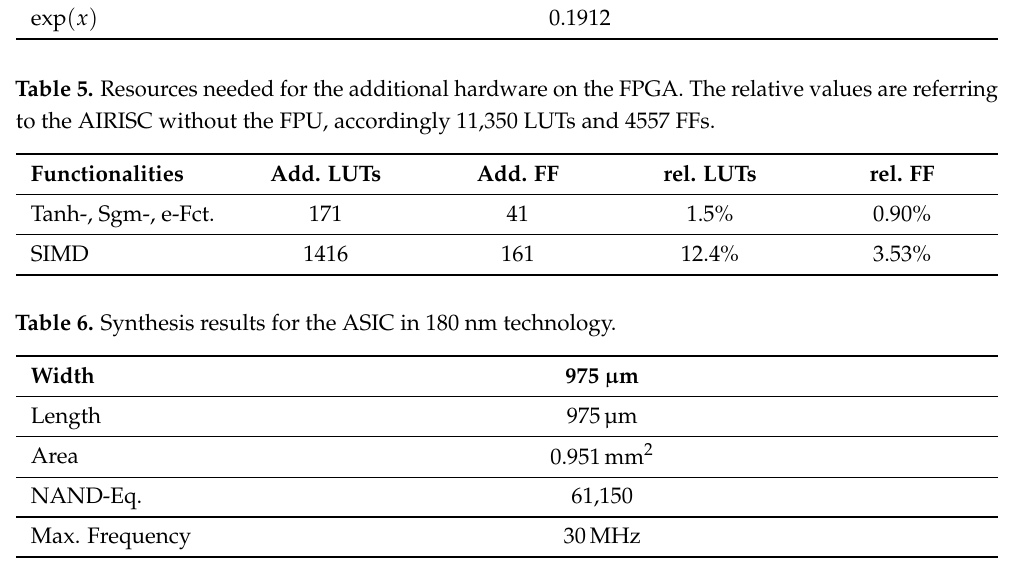
Table 7. Results for the three MicroNets with their different activation function, abbreviation (Abrv.) for Figure 9, if hardware accelerators were used (HW) or purely software activation functions, runtime (RT) without and with SIMD in clock cycles as well as accuracy, Sensitivity, specificity and F1-Score to evaluate the performance of the hardware. Arrows indicating the direction of optimization.